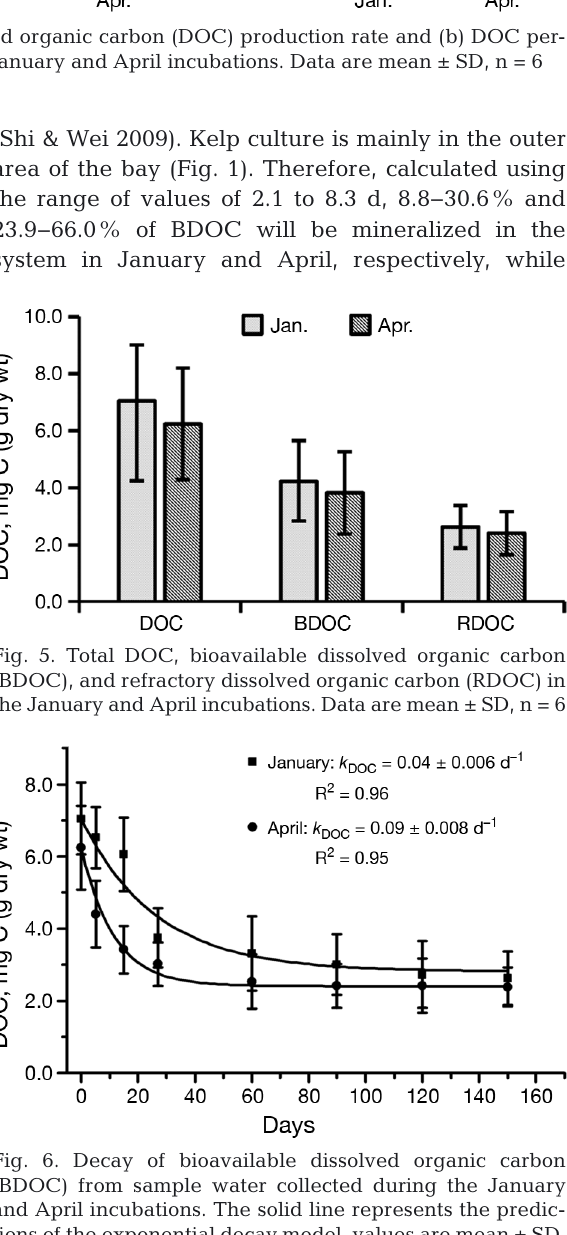
Fig. 3. Primary production of kelp in the January and April incubations. Data are mean ± SD, n = 6